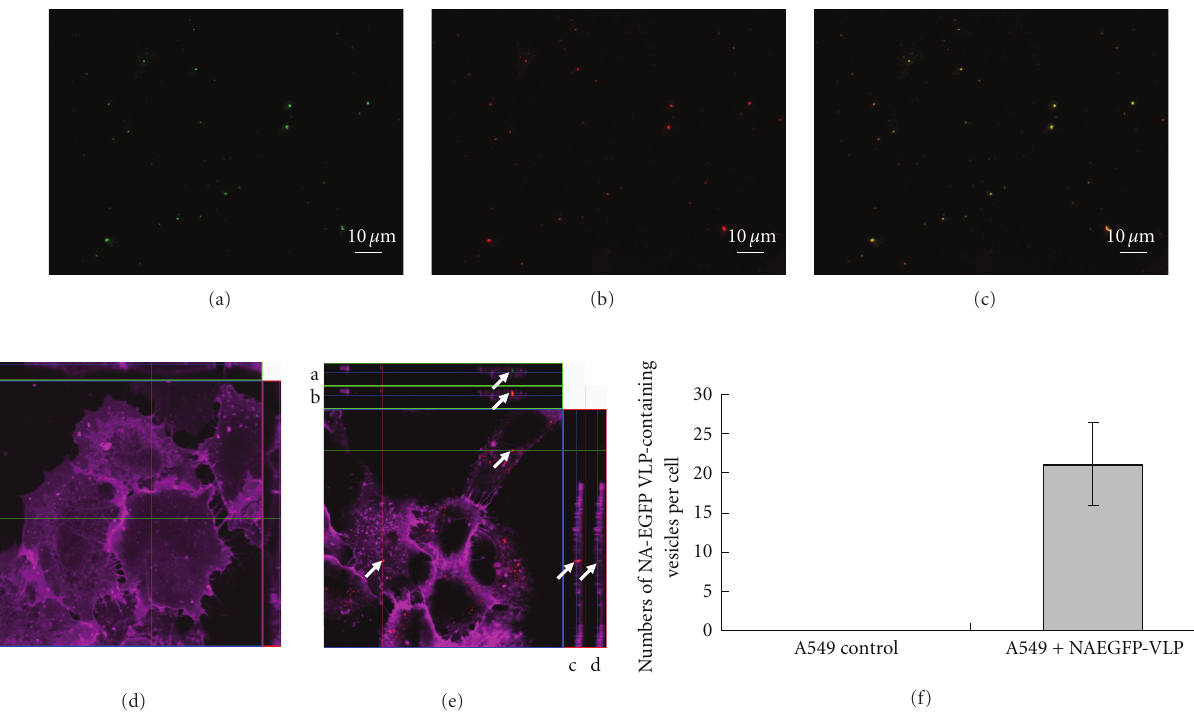
Figure 6: Endocytosis of NA-EGFP incorporated VLP in A549 cells. The NA-EGFP VLPs were stained with R18 dye. Panels (a) and (b) show the EGFP and R18 signals, respectively. Panel c displays the superimposed images of panels (a) and (b). Panel (e) illustrates the endocytosis of NA-EGFP VLP in A549 cells with panel (d) as a mock control. The upper and right rectangular images of panel (d) and (e) depict horizontal and vertical cross-sections located at green and red lines, respectively. Rectangular images of a and d show the EGFP signals (green) whereas those of b and c show the R18 signals (red). The A549 cells were stained with DiD dye (pink). Graph (f) displays the average number of endocytosed vesicles containing NA-EGFP VLP per